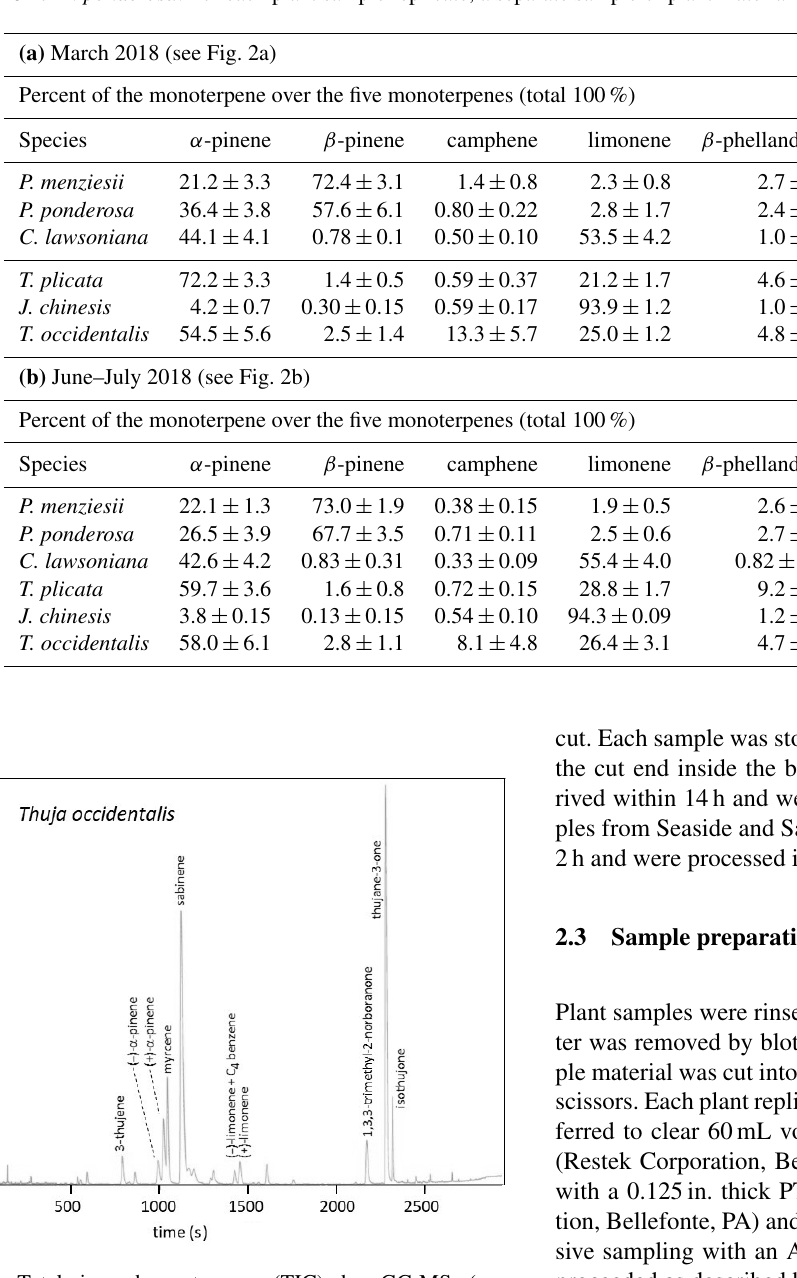
Table 2. Mass fraction values (including both enantiomers) for each of five chiral monoterpenes over those five monoterpenes and average values of ( (cid:54) 5 /(cid:54) all ) × 100% (mass fractions for the mass sum for those five terpenes over all detected monoterpenes). The nursery-purchased plants were located at PSU and sampled in March 2018 and again in June–July 2018. Number of plant sample replicates N = 4 for all species, except N = 3 for P. ponderosa . For each plant sample replicate, a separate sample of plant material was analyzed once.